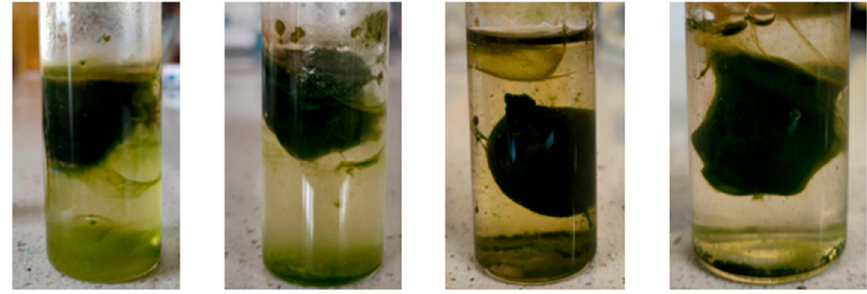
Figure 1. Maturated OPGs of sphere shape obtained during static cultivation (own study).